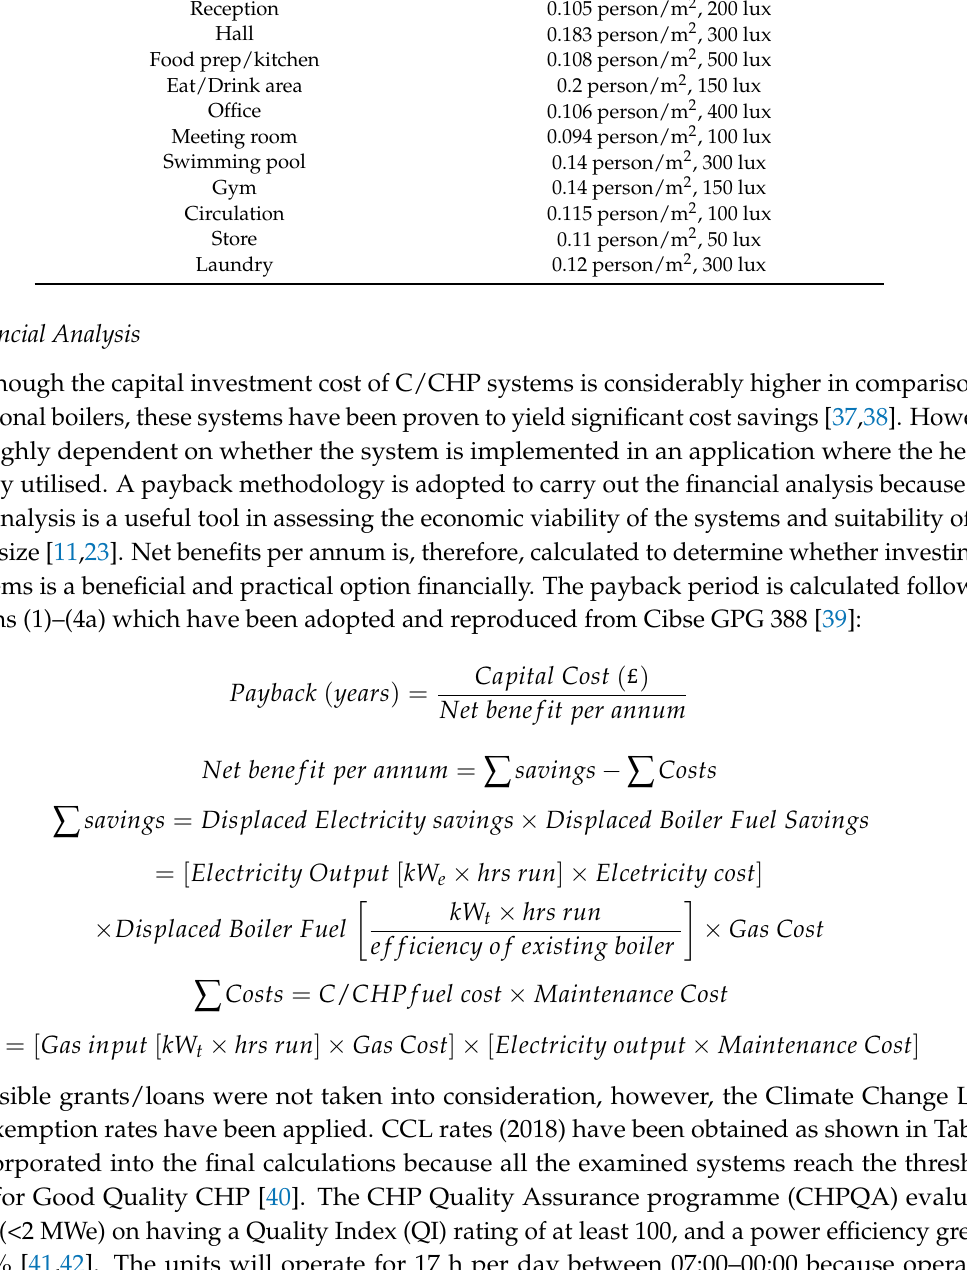
Table 2. Summary of financial